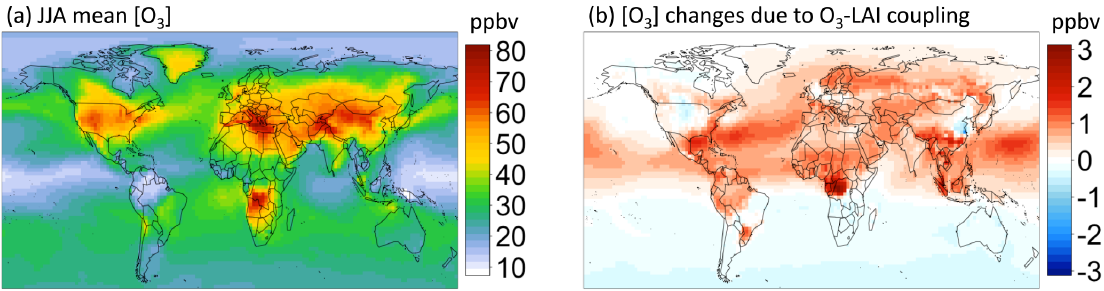
Figure 3. (a) Surface ozone concentration with ozone-affected leaf area index (LAI) in boreal summer (JJA mean) from the Affected_LAI case, and (b) differences in JJA ozone concentration between the Affected_LAI and Intact_LAI case (i.e., Affected_LAI – Intact_LAI).